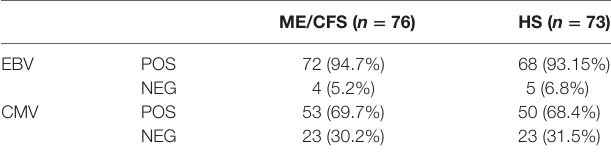
Table 3 | Prevalence of positive and negative IgG anti-Epstein–Barr virus (EBV) VCA and CMVH serology, in myalgic encephalomyelitis/chronic fatigue syndrome (ME/CFS) patients and healthy subjects.